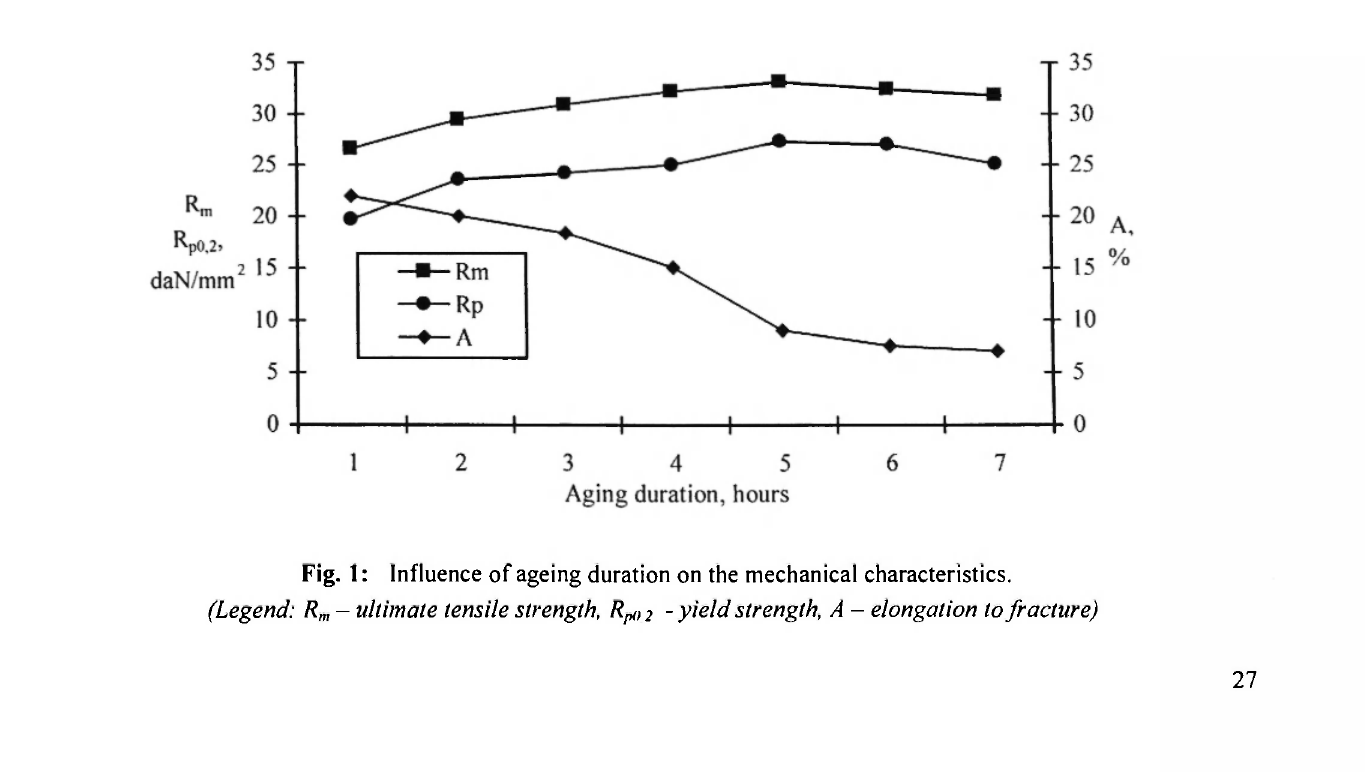
Fig. 1 : Influence of ageing duration on the mechanical characteristics. (Legend: R„, - ultimate tensile strength, R n „ 2 - yield strength, A - elongation to